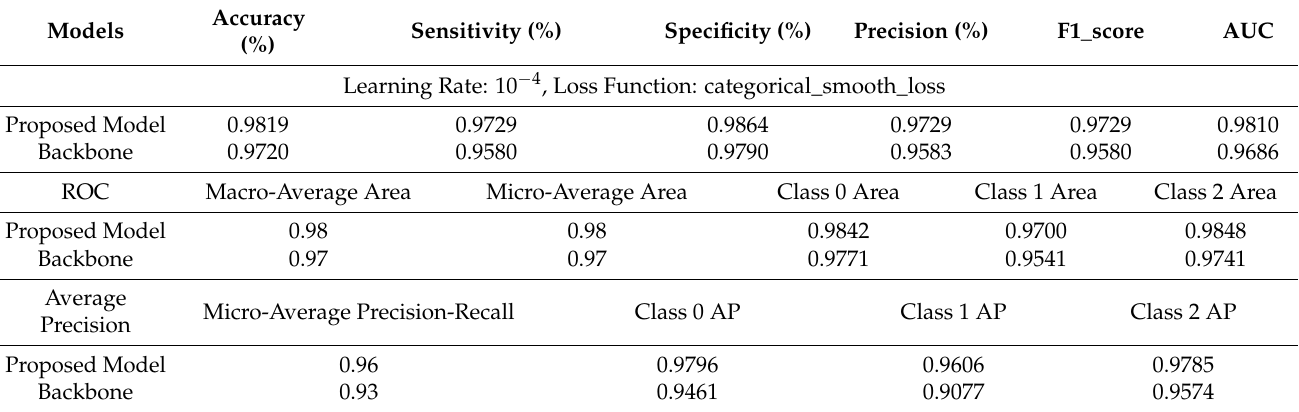
Table 10. Classification results of the backbone vs. proposed model using Data_B.